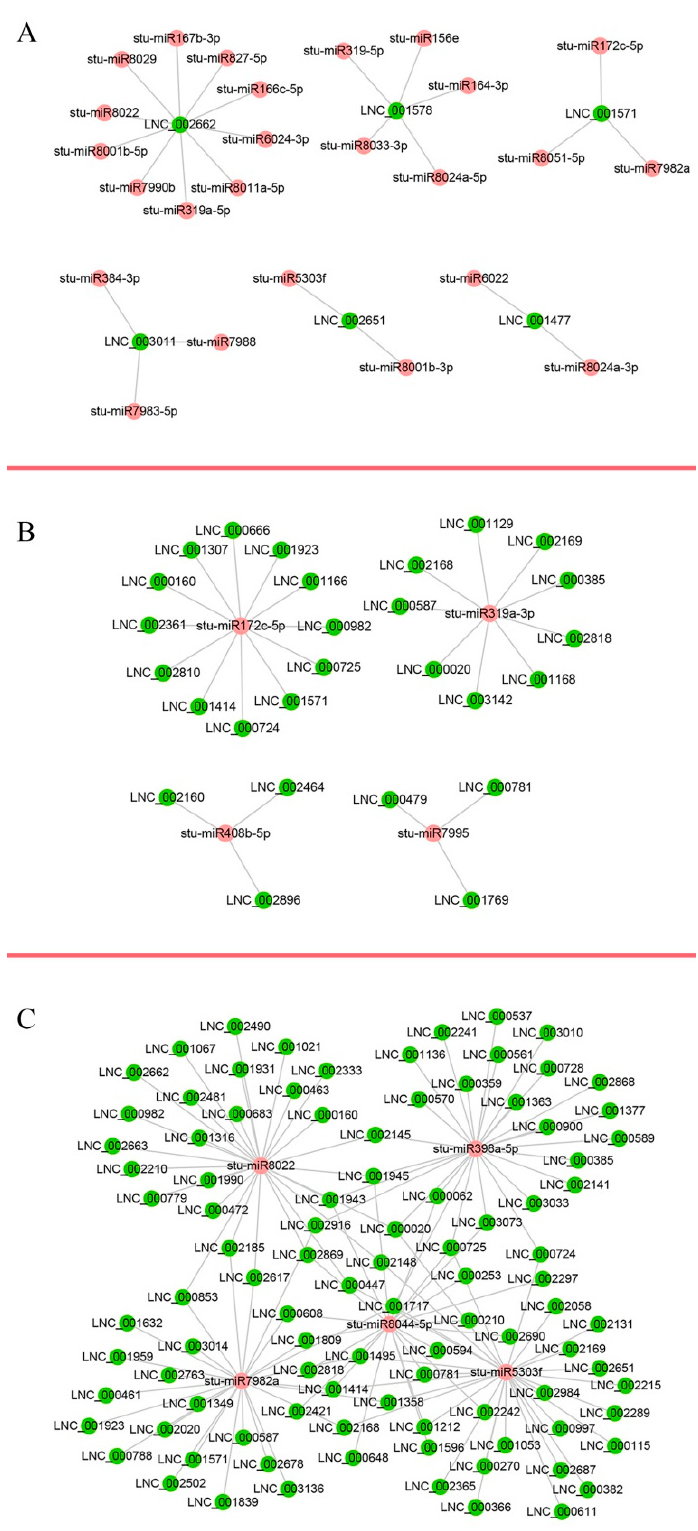
Figure 5. LncRNA-miRNA interaction network. The network includes lncRNAs and miRNAs. Red circle nodes represent miRNAs, and green circle nodes represent lncRNAs. Examples of one lncRNA to many miRNAs ( A ), many lncRNAs to one miRNA ( B ), and many lncRNAs to many miRNAs ( C ) interactions are shown.